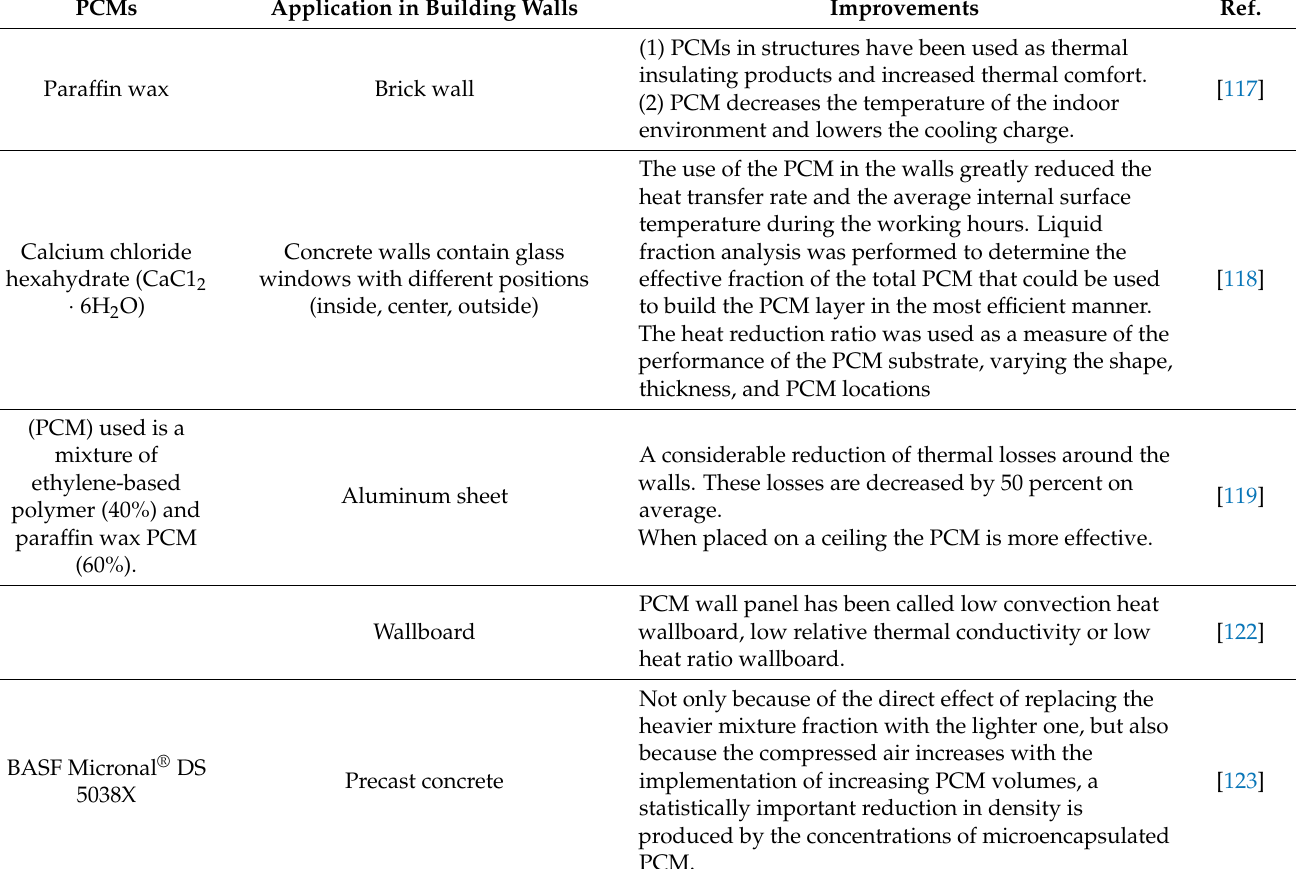
Table 9. Summary of different experimental studies in 2018 from the literature on wall applications.